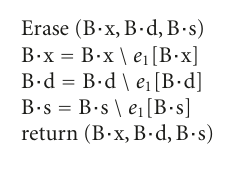
Algorithm 3: The pseudocode of the erase algorithm.